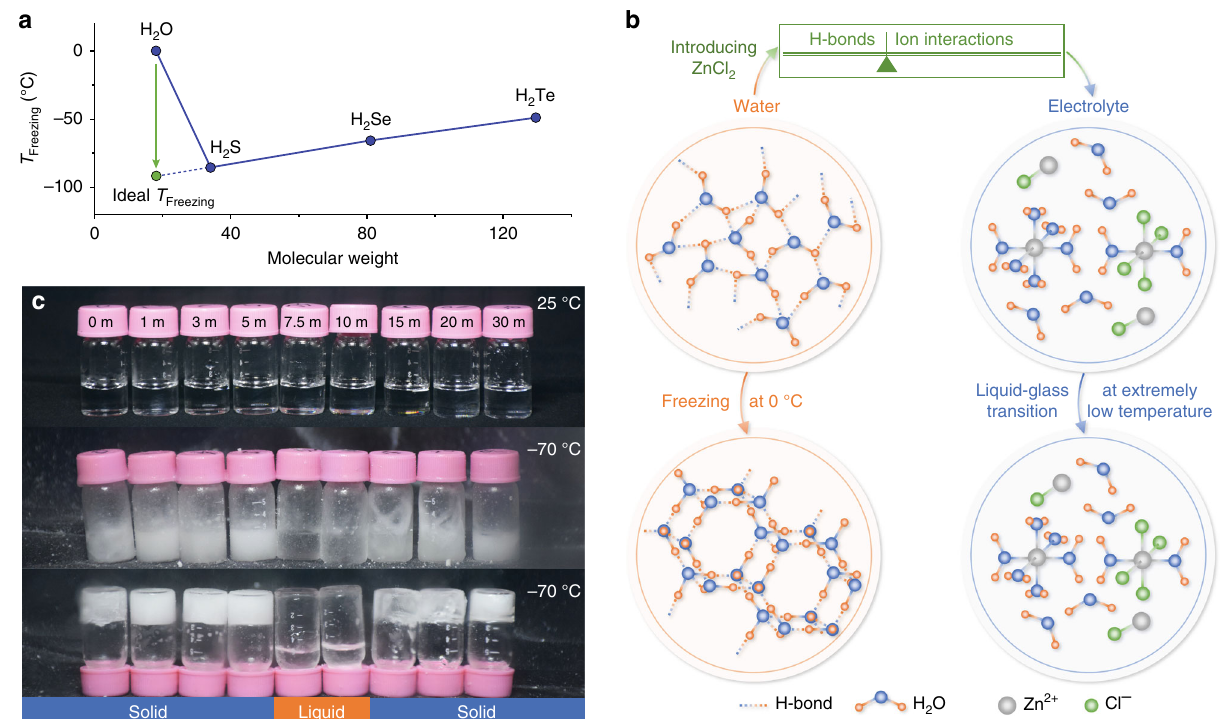
Fig. 1 The schematic of the low-T t solution design. a The freezing point of chalcogen hydrides. H 2 O visibly deviates from the law between the freezing point and molecular weight. The ideal freezing point is marked in the extended line. b The schematic of the structure evolutions of water and electrolyte, and the design of low-T t solution. Original water network linked by H-bonds can easily transform to ice network at 0 °C. After adding ZnCl 2 , the H-bond network is broken by the strong interaction between ions and water, while the ion interactions are enhanced. By balancing the H-bonds and ion interactions for modulating T t , the electrolyte at critical C ZnCl can be operated at extremely low temperature. c The optical photographs of different C ZnCl electrolyte at 2 2 25 and − 70 °C. At − 70 °C, the electrolyte owning low/high C ZnCl is solid, while the moderate C ZnCl (7.5 – 10 m) electrolyte remains 2 2